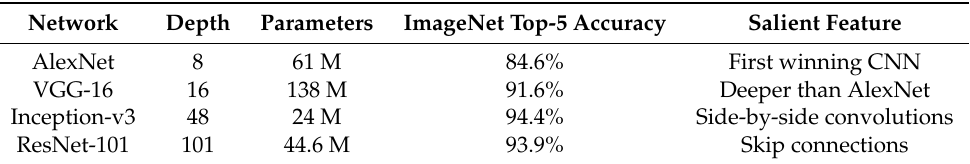
Table 1. Summary of the main differences between AlexNet, VGG-16, Inception-v3 and